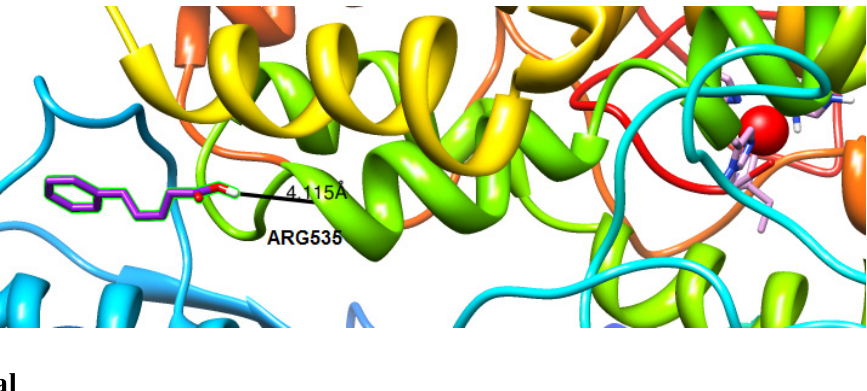
Figure 2. Docked poses of conjugate 3ii (Purple) in the LOX binding site. Ball and stick models are used to render the side-chains of relevant binding site residues. The iron ion is depicted as an orange